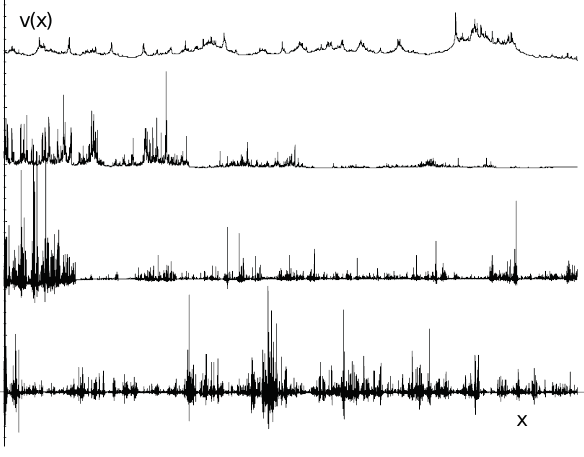
Fig. 1. This shows samples of the simulations analysed in Sect. 5. From bottom to top, H = − 7 / 10 , − 3 / 10 , 3 / 10 , 7 / 10. All have C 1 = 0.1, α = 1.8; the sections are each 2 13 points long. One can clearly see the change in character of the series when H changes sign. At the bottom, fluctuations tend to cancel out, fluctuations are “stable”. At the top, they tend to reinforce each other, and fluctua- tions are